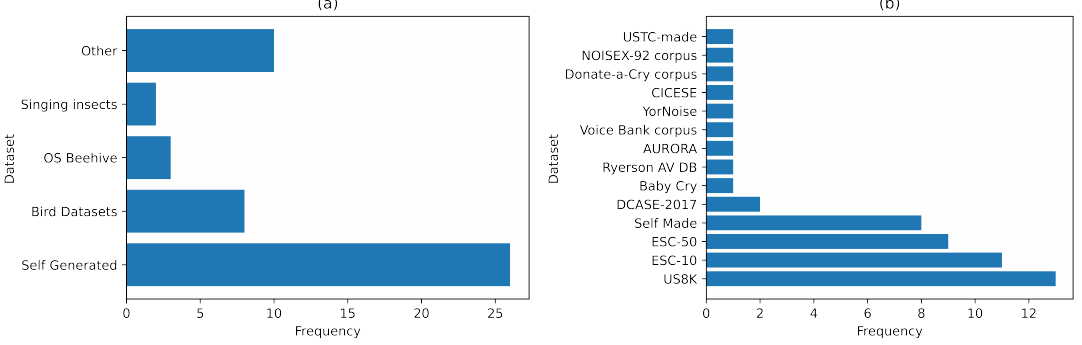
Figure 8. Data sets used for ( a ) bioacoustics and ( b ) general acoustics studies.